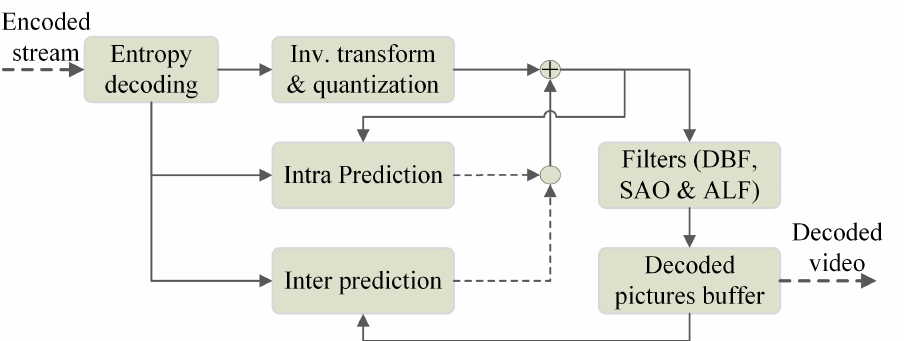
Figure 1. General block diagram of a VVC decoder.